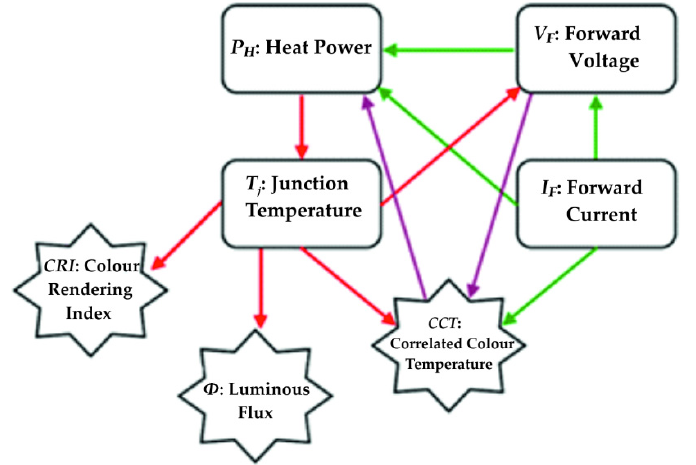
Figure 1. Relationships between junction temperatures T j , lighting parameters, and electrical parameters.